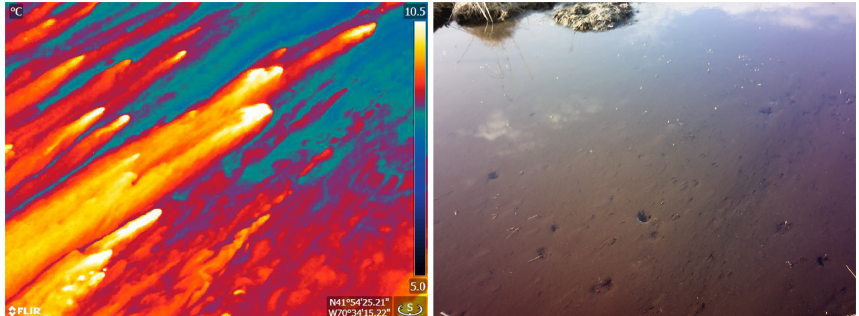
Figure 6. Thermal infrared (TIR) image from 21 March 2014 at Tidmarsh Farms illustrating PFP (type 2) seepage. Many macropores are observed in both the infrared (slightly smaller) and the visual image. These seeps are located in the middle of cell 3 (Fig. 1b), where peat is ∼ 3m thick and dramatically